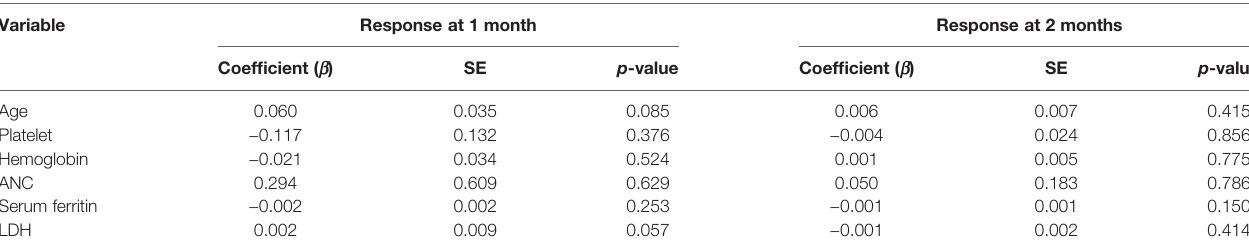
TABLE 2 | Univariable logistic model for platelet response.